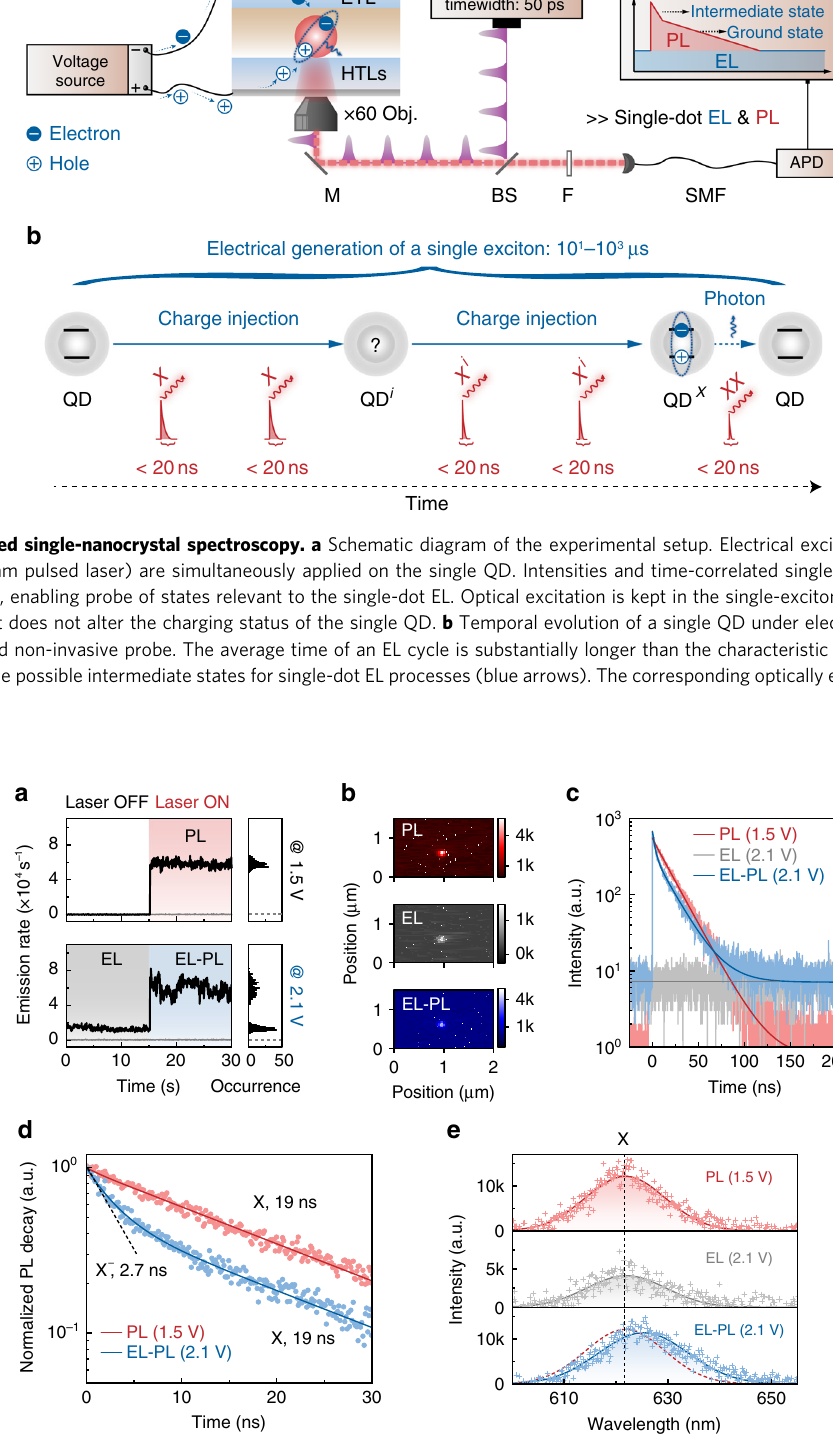
Fig. 2 QD − as the intermediate state for the electrical generation of a single exciton. a Intensity – time traces of a single QD under different excitation conditions. “ PL ” (red shaded regions), “ EL ” (grey-shaded regions) and “ EL-PL ” (blue shaded regions) traces correspond to emissions recorded under optical excitation, electrical excitation and simultaneous optical and electrical excitation, respectively. Grey lines are background counts. b Microscopy images of the single QD under different excitation conditions. c TCSPC data of PL (red), EL (grey) and EL – PL (blue) emissions. The data of EL emission (grey), which matches with the baseline of the EL – PL emission, is also shown. d PL decay for the single QD with electrical injection (blue) or without electrical injection (red), extracted from c . Solid lines are exponential fi ts and the dashed line is for visual guidance. e Single-dot spectra measured under different conditions. The single-exciton PL spectrum (red-dashed line) is also shown at the bottom for